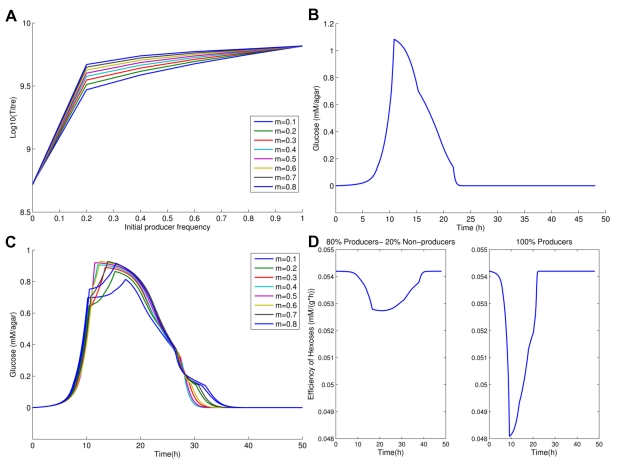
The role of the rate-efficiency trade-off and the dynamics of sugar metabolism.(a) Expected final population size (Log(titre)) after exhaustion of resources as a function of initial producer frequency in the absence of rate-efficiency trade-off. The temporal glucose spike, with glucose measured in mM/agar and time represented in hours, (b) when initially all the population are producers and (c) when 80% are producers with glucose measured in mM/agar and time is in hours. Note that the spike in (c) is lower and longer-lived, hence glucose is used more efficiently. (d) Efficiency of hexose usage by producers (g protein/mM hexose) when non-producers are present (80∶20 ratio: left hand panel) and when they are absent, i.e. 100% producers (right hand panel). Here we average across spatial structures.